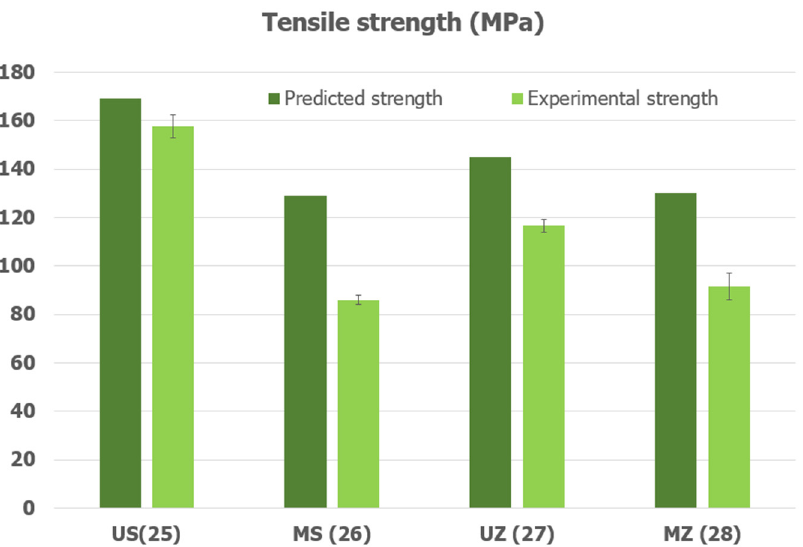
Figure 3. Predicted and experimental axial strengths for the four conditions M = mercerised, S = silane in hardener, U = not mercerised, Z = no silane in hardener.